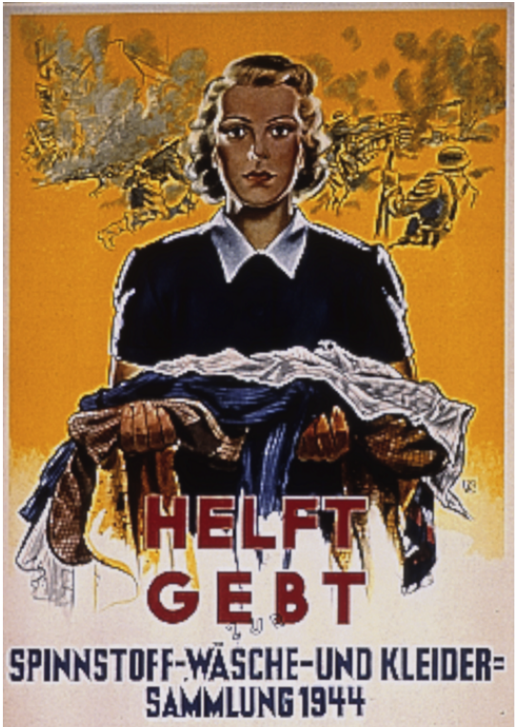
Figure 8 "Help: give to the textile, linens, and clothing collection drive, 1944," 1944. Poster Collection, Hoover Institution Archives, GE